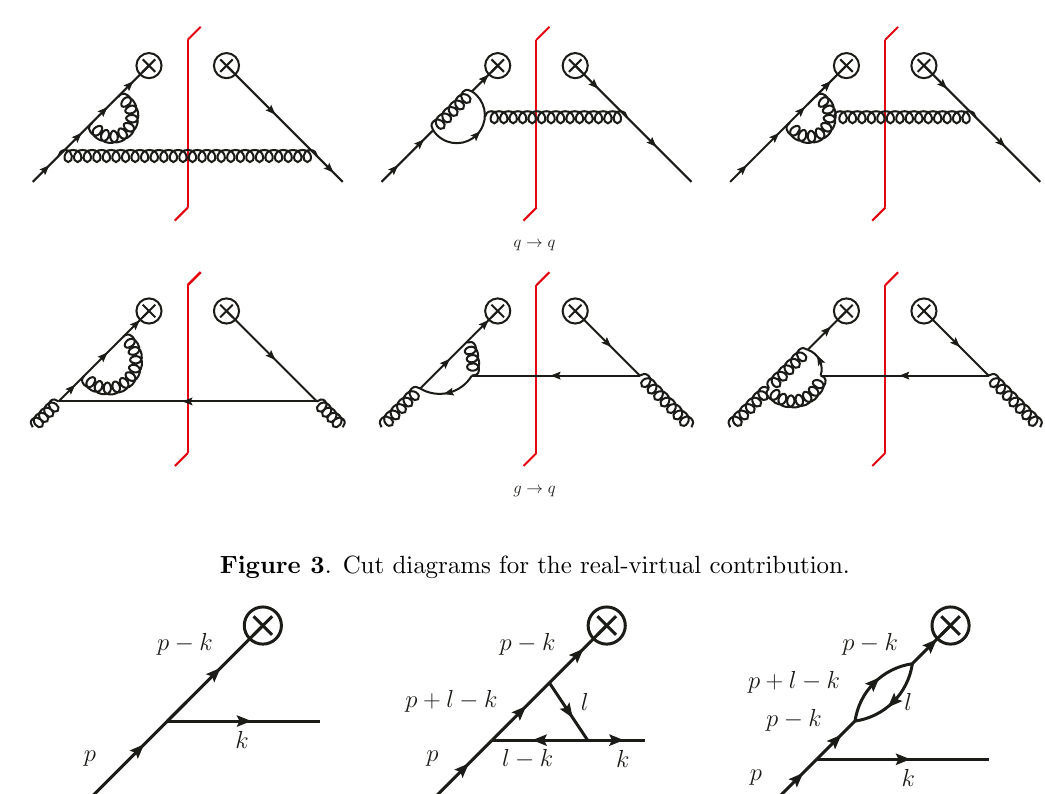
Figure 4 . Topologies for the real-virtual